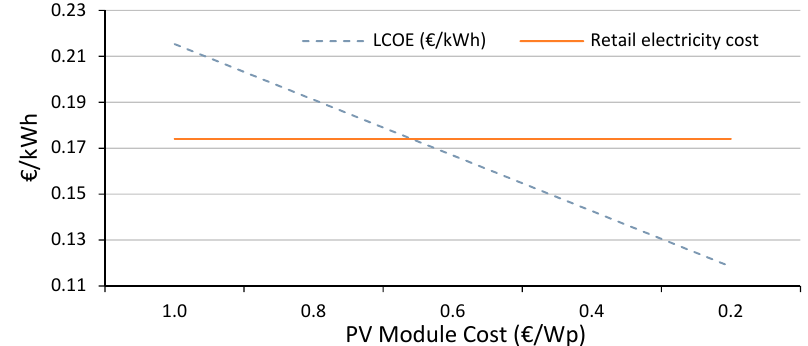
Figure 9. Analysis of the LCOE against the regulated tariff at a fixed interest rate of 10% (50,000 W inverter, deterministic method).